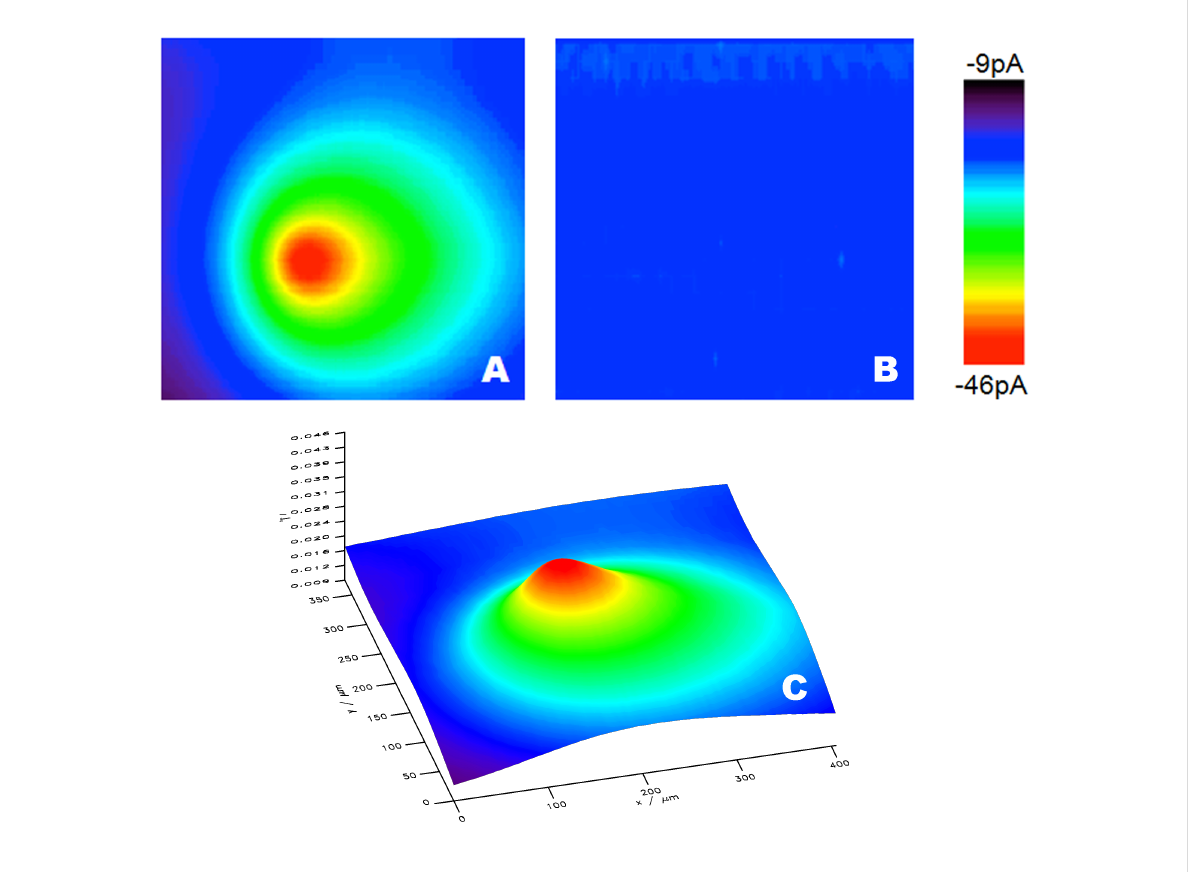
Figure 4: SECM image of an H 2 O 2 -generating gold electrode (diam. of 25 µm). A and B are 2D plots of images recorded with a platinum UME (diam. of 25 µm) covered with three layers of PB–Ni–HCF and with Ni–HCF, respectively. C illustrates a 3D plot of A.